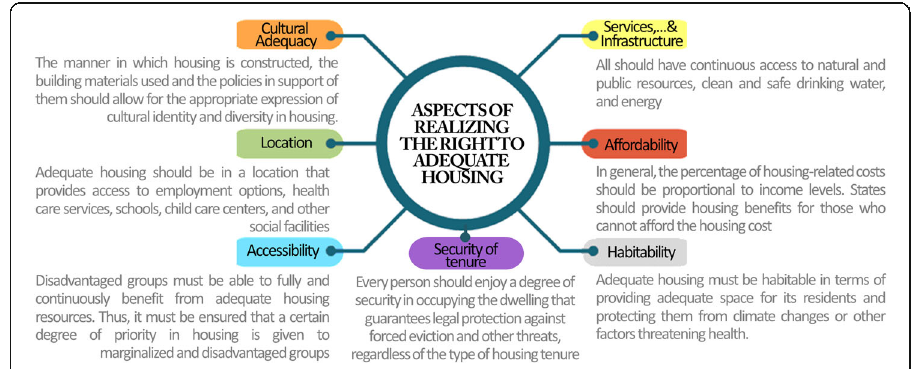
Fig. 2 The seven key aspects of the right to adequate housing (The first author based on General Comment No. 4, Art. 11(1), UN-CESCR,